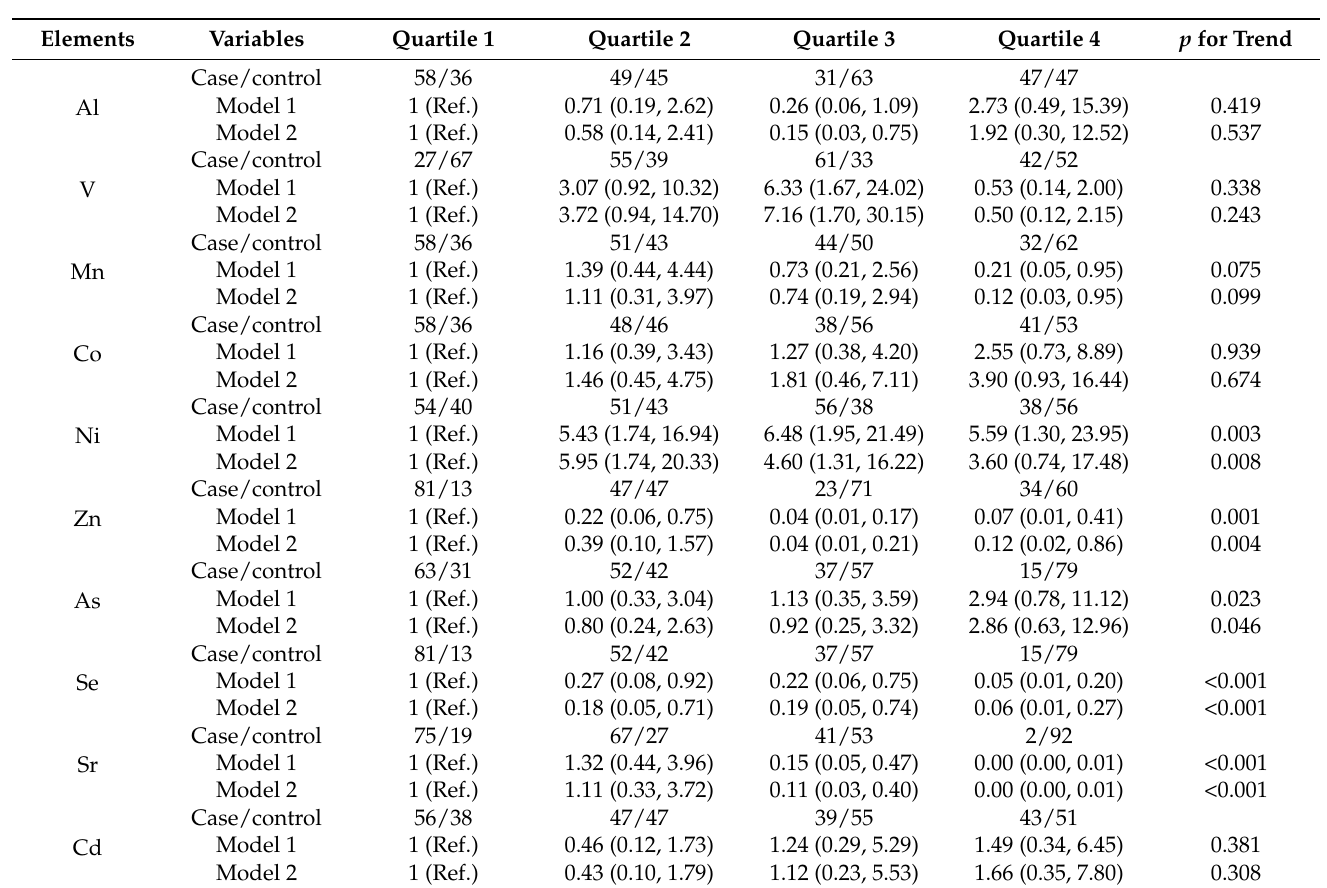
Table 3. Odds ratios (ORs) and 95% confidence intervals (95% CIs) for multiple serum trace elements associated with